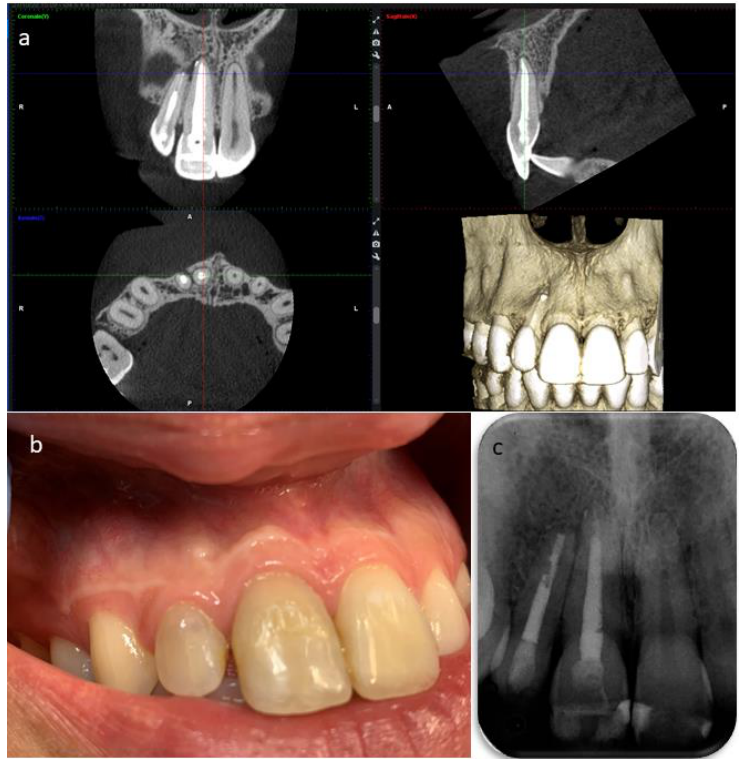
Figure 8. Follow-up at three years. ( a ) Post-operative CBCT performed at three years. ( b ) Clinical examination at three years revealing healthy soft tissues at the periapical area. ( c ) Periapical radiograph taken after three years postoperatively.